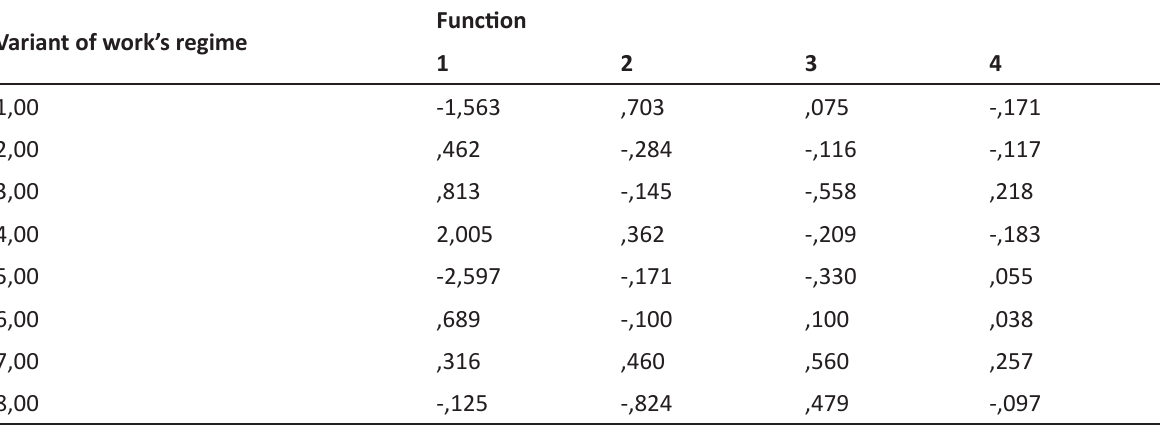
Table 5. Functions in centroid groups. Boys 8 years old Variant of work’s